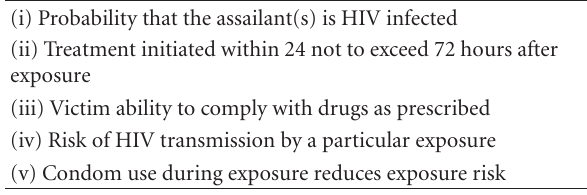
Table 2: HIV transmission risk from known HIV seropositive